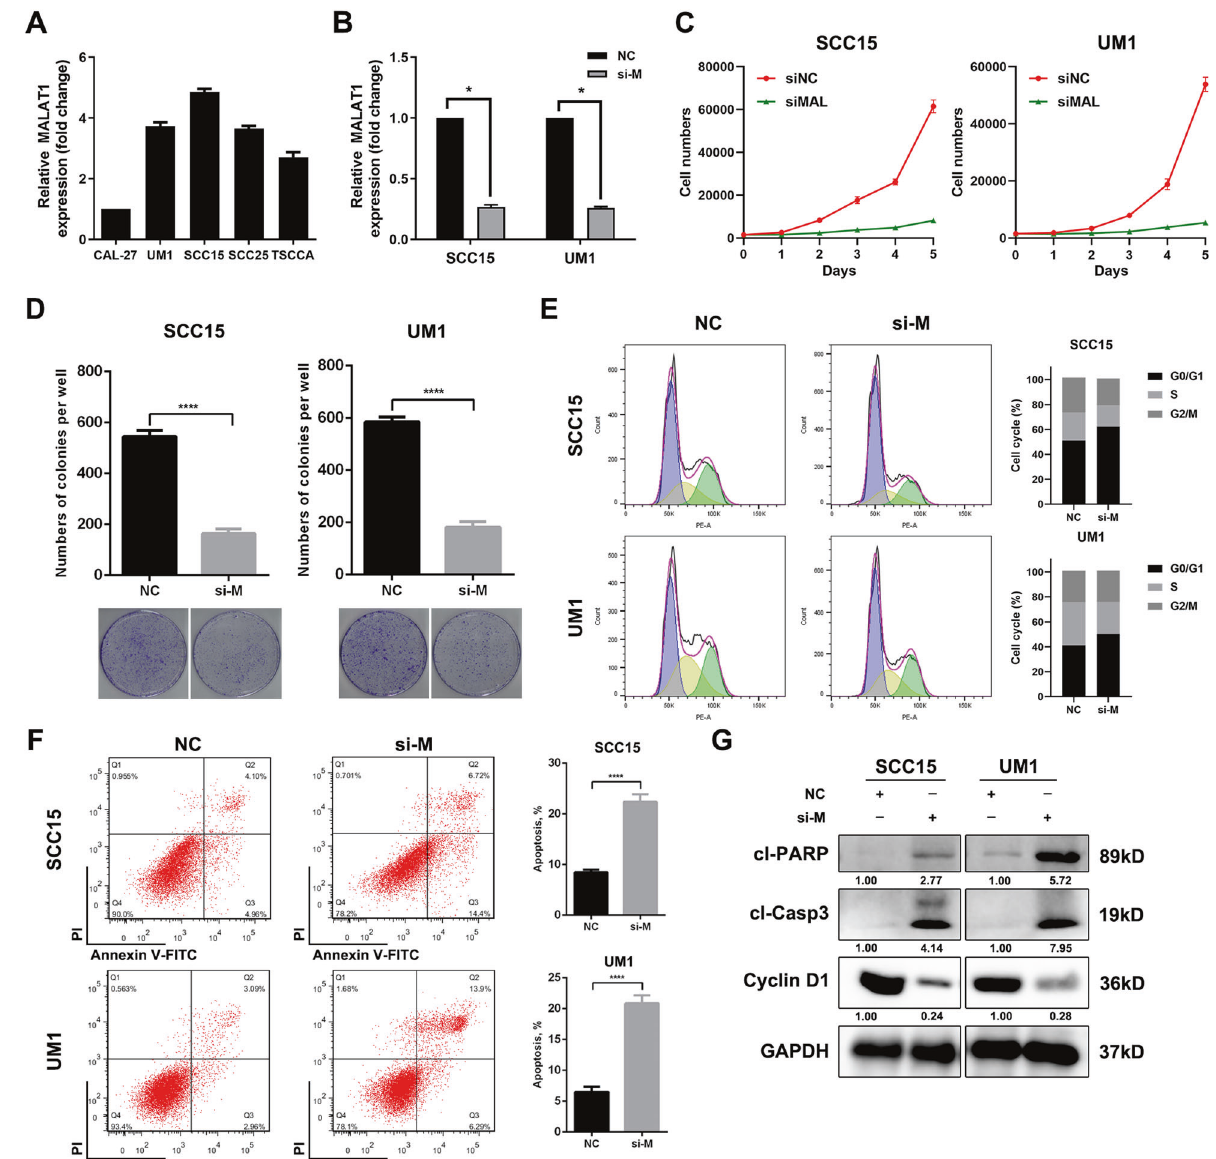
Fig. 2 MALAT1 depletion inhibits proliferation and promotes apoptosis of HNSCC cells in vitro. A The level of MALAT1 was measured in a panel of HNSCC cell lines using qPCR assay. B The expression of MALAT1 was detected using qPCR assay in the SCC15 and UM1 cells transfected with a pool of three siRNAs targeting MALAT1. C The effect of MALAT1 knockdown on the growth of SCC15 and UM1 cells in vitro was assessed through cell counting. Bar, SD for quintuplicate wells. siNC, negative control for siRNA. siMAL, si-MALAT1. D MALAT1 depletion signi fi cantly weakened the capacity of colony formation of HNSCC cells. Bar, SD for triplicate wells. E The results of fl ow cytometry showed that MALAT1 silencing induced G1 phase arrest in SCC15 and UM1 cells. F HNSCC cells were transfected with MALAT1 siRNAs for 48h, then cell apoptosis rate was measured by fl ow cytometry. G The abundance of cleaved PARP, cleaved Caspase-3 and Cyclin D1 was probed in MALAT1-depleted HNSCC cells and the negative control group. Data in this fi gure, mean±SD, * P <0.05, ** P <0.01, **** P <0.0001. NC negative control. si-M,